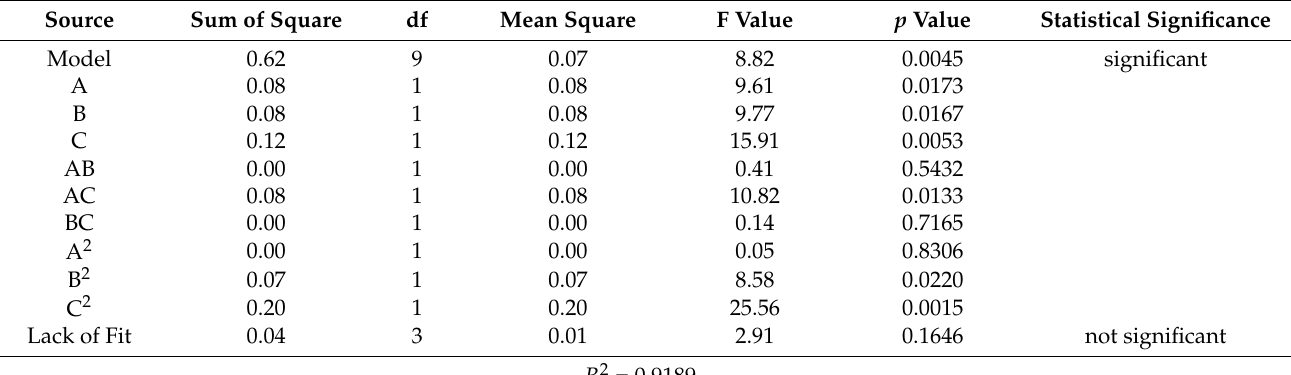
Table 8. Analysis of the variance of OD value fitting